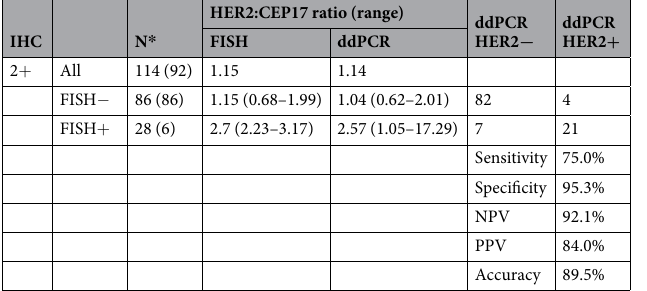
Table 3. Performance of RainDance platform in validation cohort. * (Number of cases with HER2:CEP17 ratio by FISH analysis).